Question: Provide a one-line summary of what is displayed.
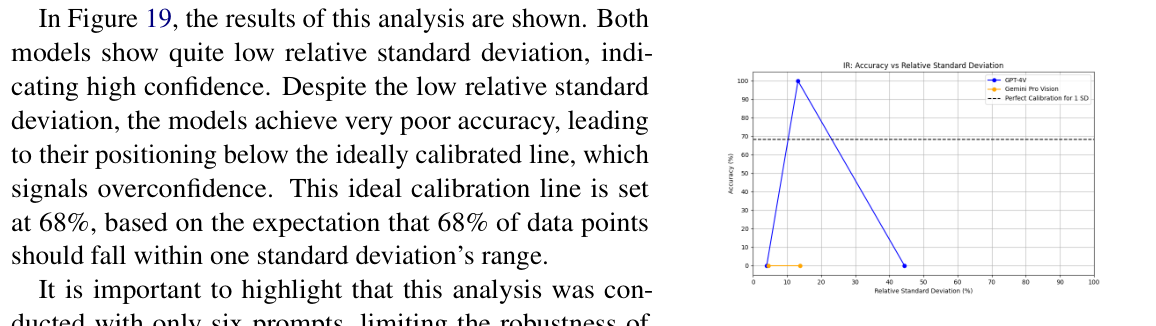
Answer: Accuracy vs. Relative Standard Deviation plot for the image recognition task with mean and standard deviation. The dotted line represents perfect calibration, indicating that with one SD, we expect 68% of the data points to lie within this range.